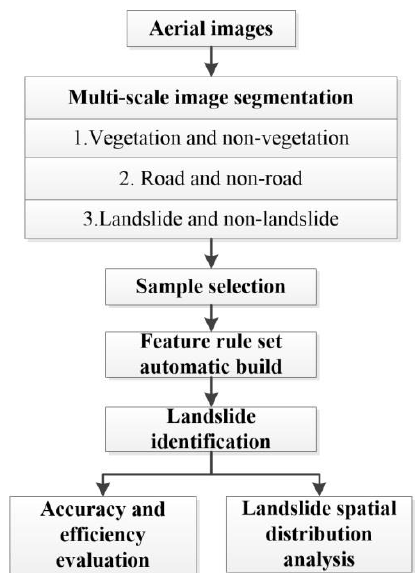
Figure 4. Technology flow chart of landslide identification and spatial distribution analysis based on object oriented